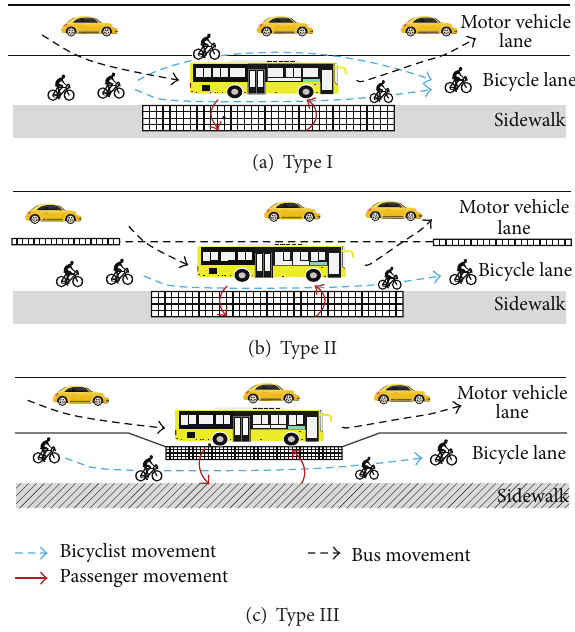
Figure 1: Three types of bus stops on secondary roads in China.